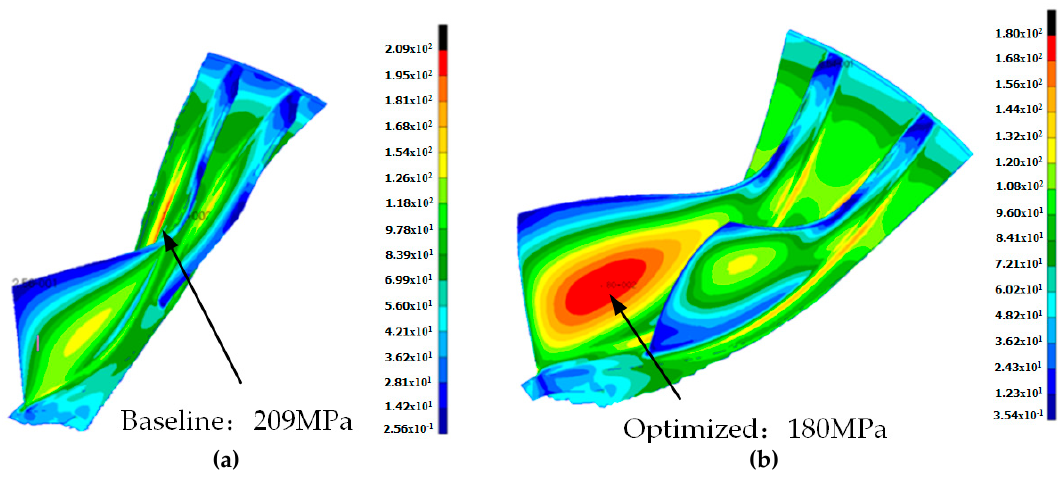
Figure 16. The von Mises stress distribution (units: MPa): ( a ) baseline; ( b ) optimized.